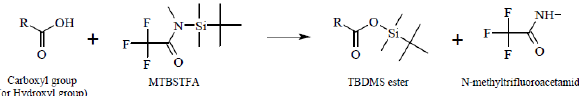
Fig. 1 . Derivatisation reaction of carbonyl compounds by the PFBHA reagent